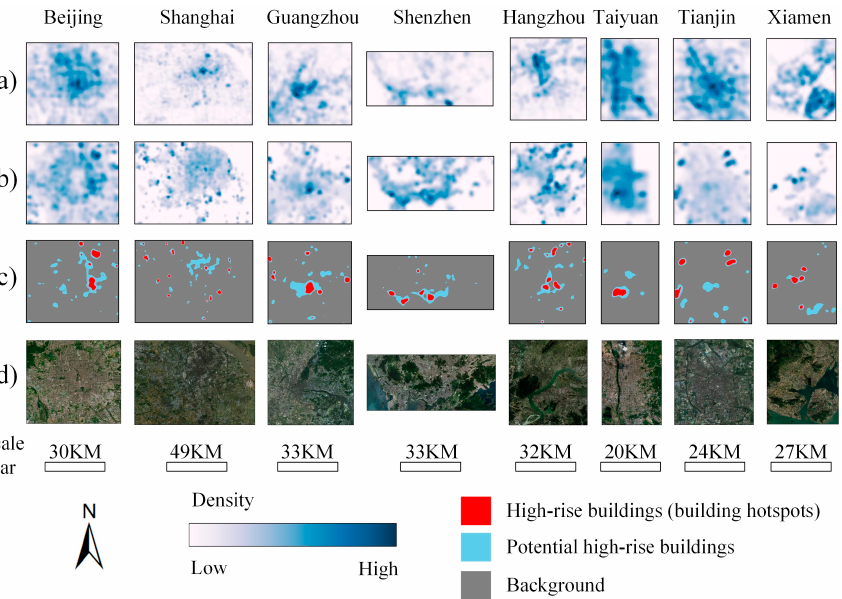
Figure 6. Kernel density maps and the extracted urban core results in eight representative cities . ( a ) road density map; ( b ) average building floor number density map; ( c ) high-rise building extraction; ( d ) satellite image map.